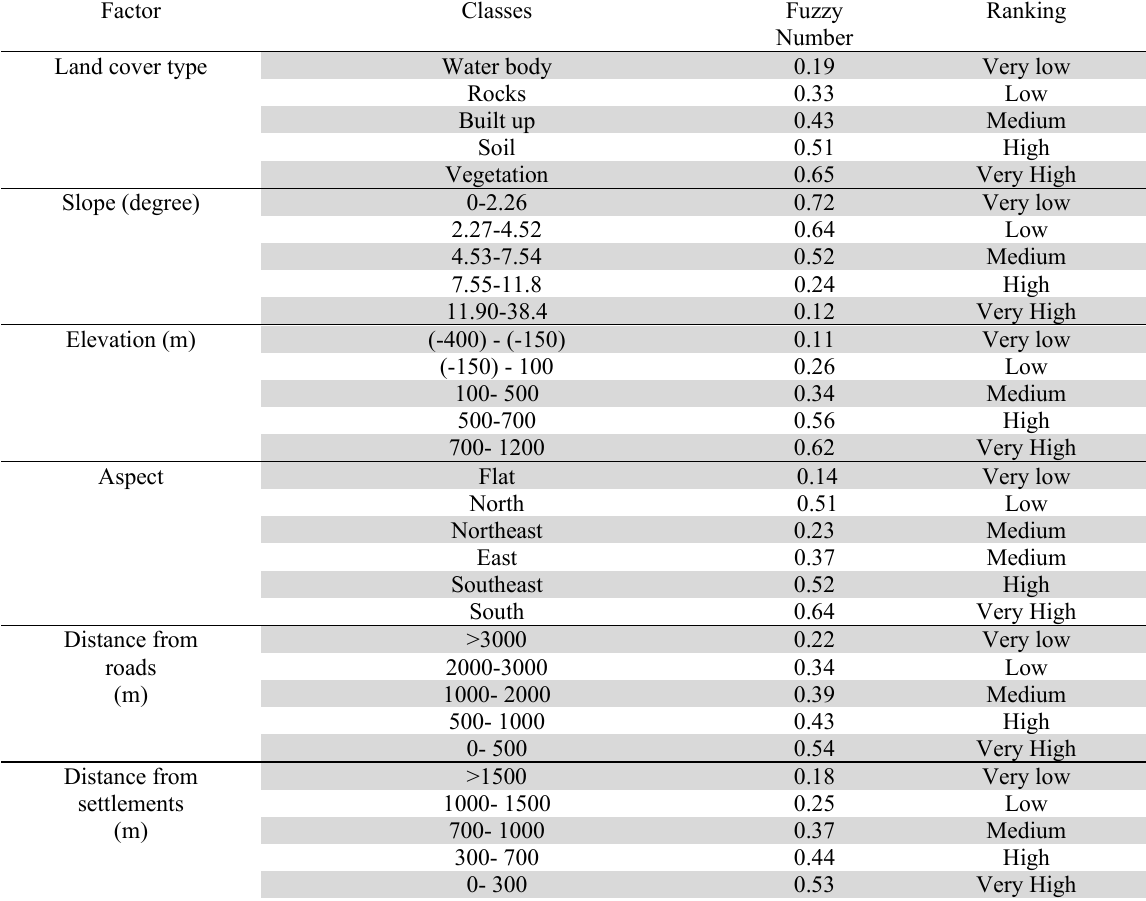
Fuzzy number of each classes and their corresponding ranking Factor